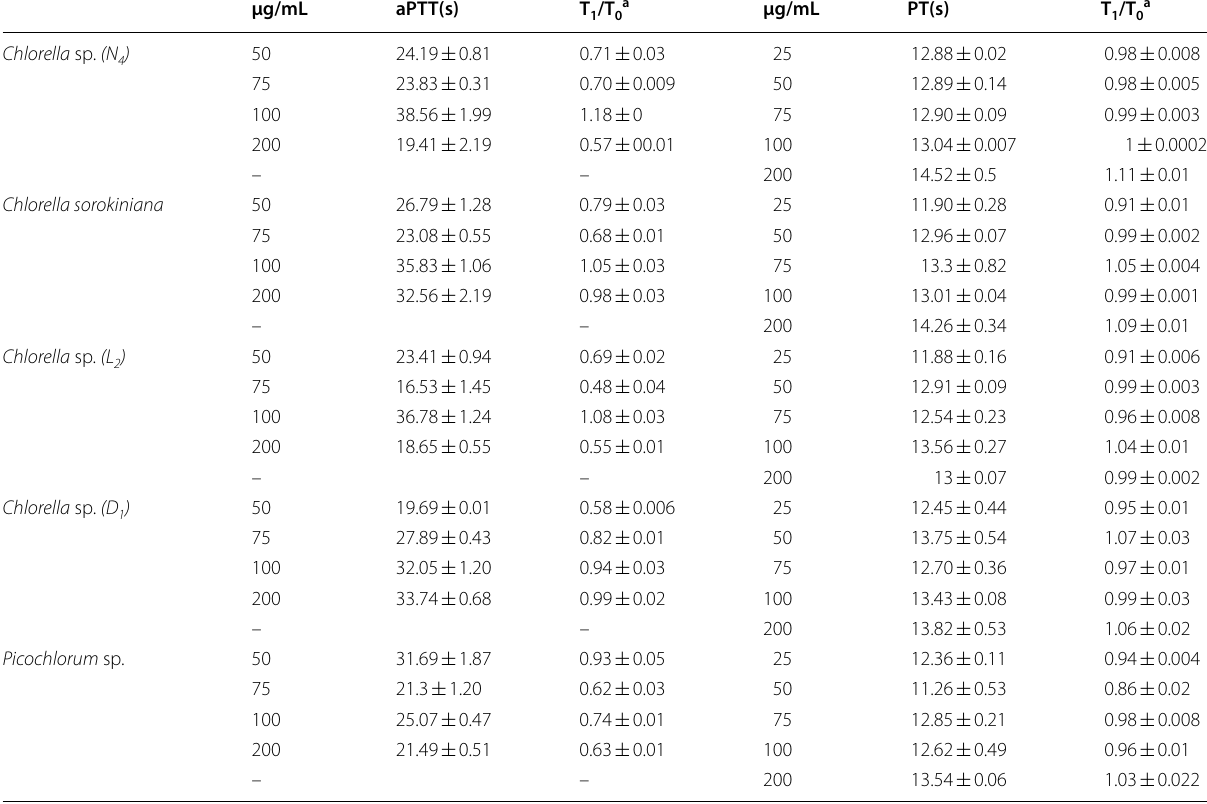
Table 4 Analysis of anticoagulant activity by aPTT and PT assay on